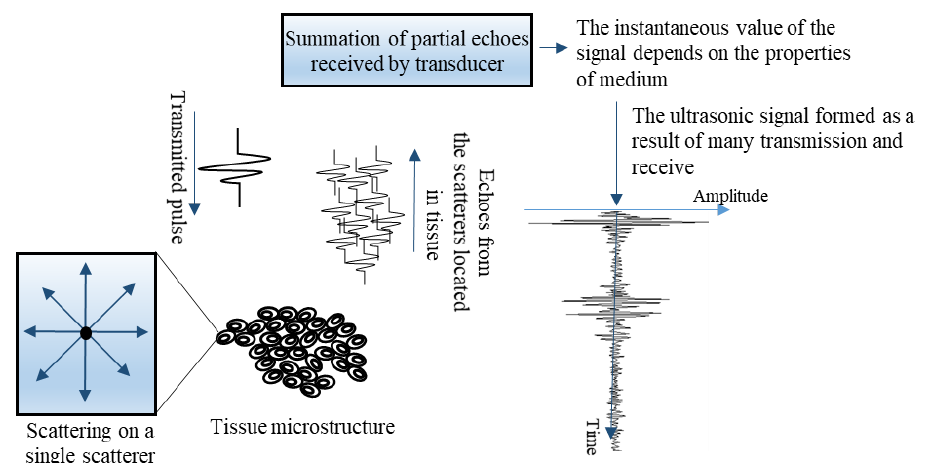
Figure 1. Diagram of ultrasonic radio frequency (RF) signal formation as a result of scattering on inhomogeneities present in the tissue.